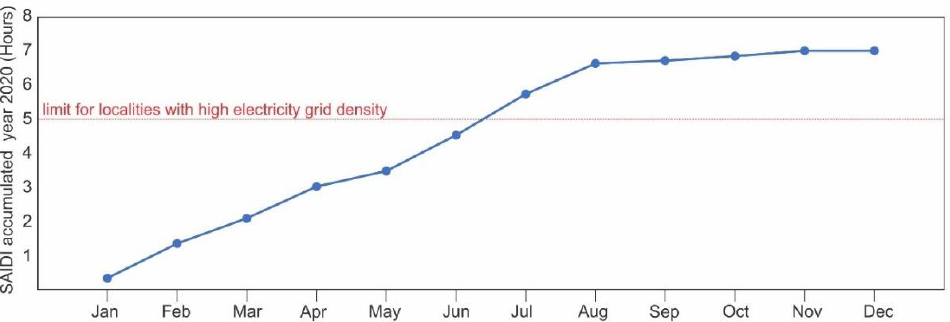
Figure 2. Monthly SAIDI accumulated during 2020 for the study location (author’s own preparation from [25]).